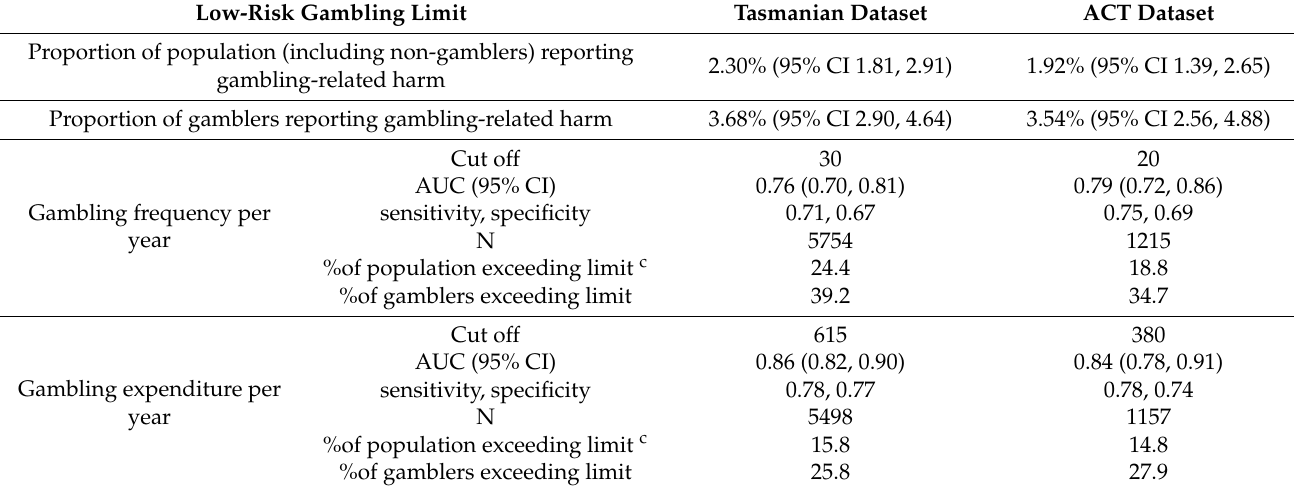
Table 2. Receiver operating characteristic (ROC) analyses for the Tasmanian and ACT data a,b . Low-Risk Gambling